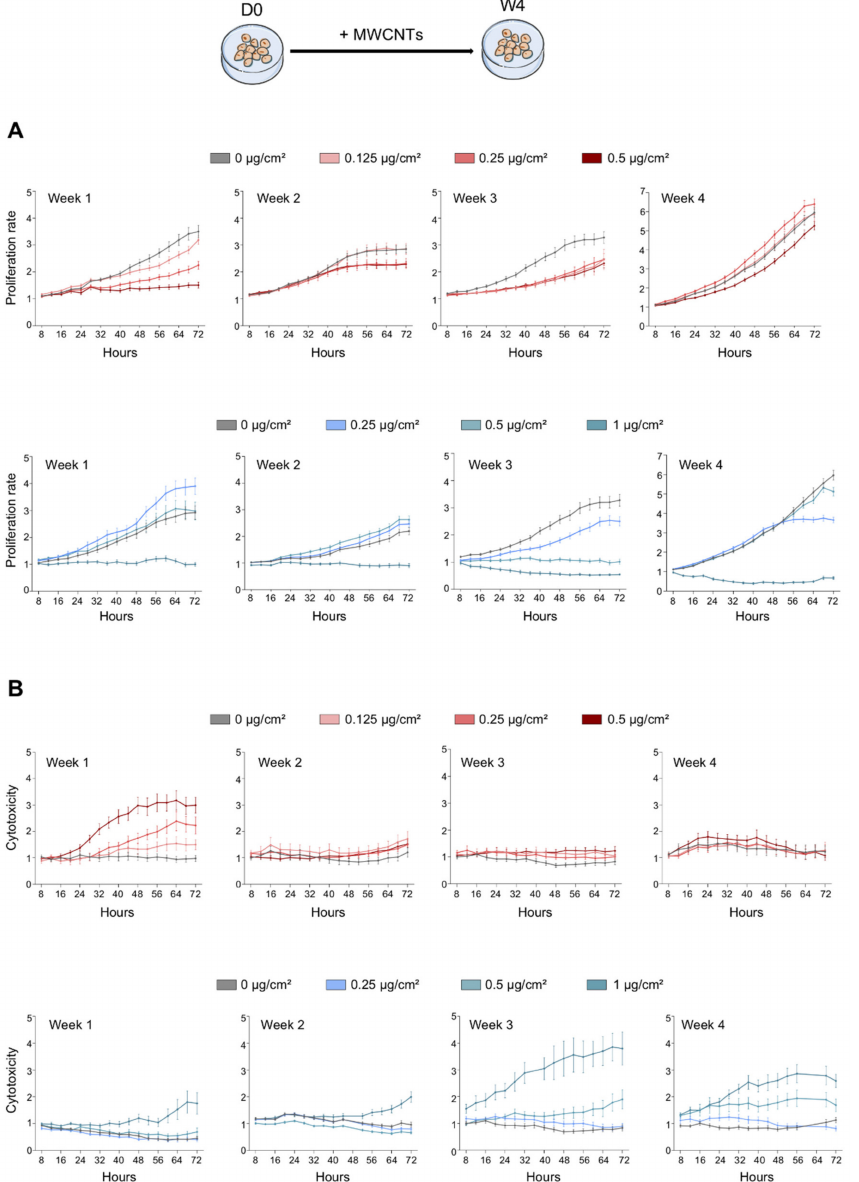
Figure 2. Antiproliferative and cytotoxic effect of MWCNTs. BEAS-2B cells were treated with Mitsui- 7 ( upper ) or NM-403 ( lower ) at the indicated concentrations for 4 weeks. ( A ) Proliferation was assessed using a NucLight probe, which labeled total cells. ( B ) Cytotoxicity assay was assessed using Cytotox and NucLight probes and the ratio of dead cells/total cells was determined. Data were normalized to the first point of acquisition after addition of the dyes (4 h). The graphs are representative of three independent